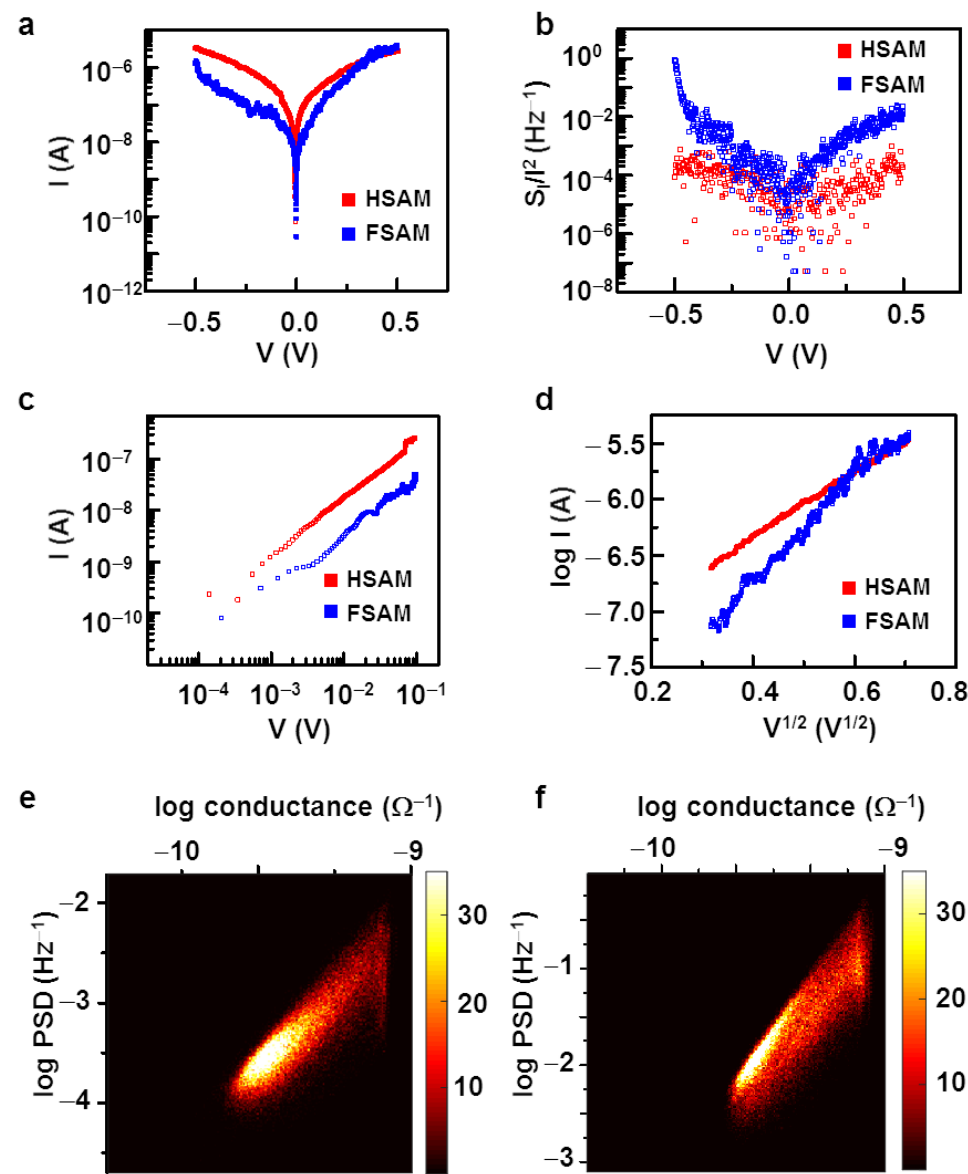
Figure 4. The effect of high biases on the conduction mechanism and noises in molecular wire junctions. ( a ) A scatter plot showing I–V curves of HSAM and FSAM on a semi-log scale. The curve was nearly symmetric for HSAM, whereas FSAM showed asymmetry and higher currents in positive bias cases. ( b ) Noise PSD dependence on the voltage for HSAM and FSAM. The noise PSD shows an asymmetric behavior in FSAM. ( c ) The I–V curves of HSAM and FSAM for low biases (below 0.1 V) on a log-log scale, showing the linear dependence of the current on voltage. ( d ) log I–V 1/2 curves of HSAM and FSAM for high biases (above 0.1 V). The linear dependence of the curves implicates thermionic emission of carriers at high biases. ( e ) A double histogram plot for noise PSD versus conductance for HSAM at a high bias, showing a positive correlation. ( f ) A double histogram plot for noise PSD versus conductance for FSAM at a high bias. The positive correlations in high bias conditions implicate a change in the conduction mechanism from tunneling to thermionic emission.